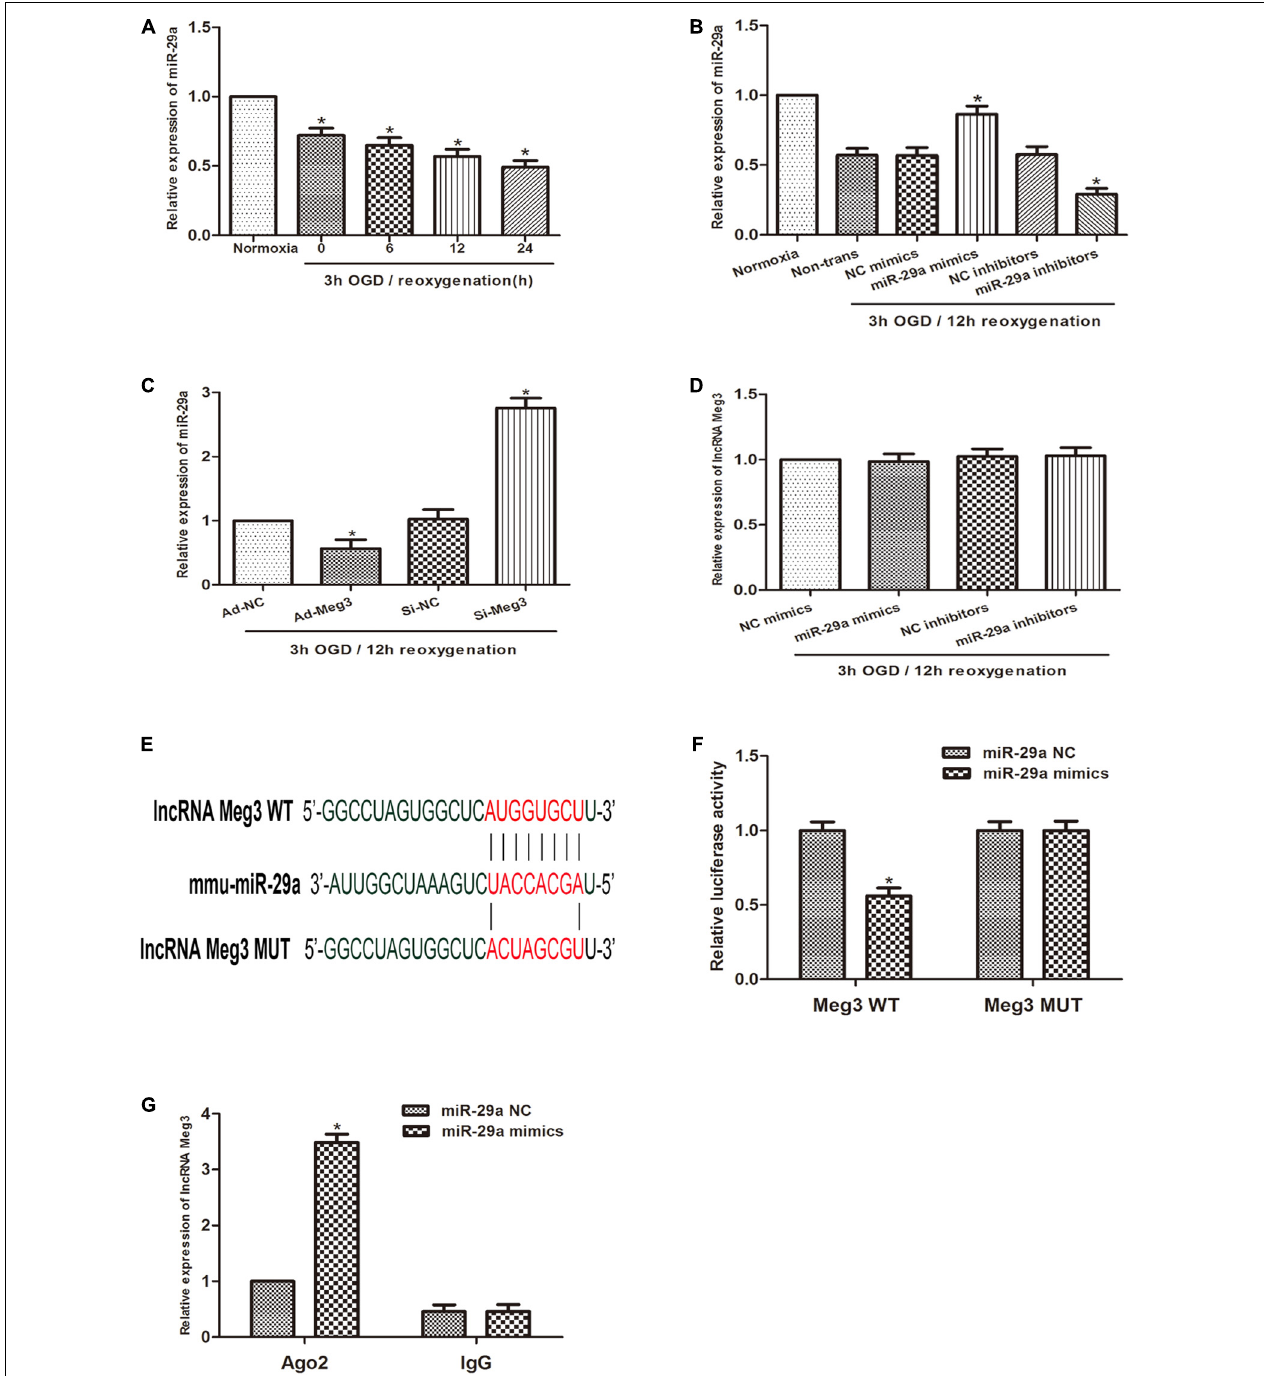
FIGURE 3 | lncRNA MEG3 inhibits miR-29a expression by directly targeting it. (A) Comparison of the relative expression levels of miR-29a between normoxic group and GC-1 cells at different reoxygenation times (0, 6, 12, and 24 h) after 3 h of OGD treatment. (B) Comparison of the expression level of miR-29a in cells transfected with miR-29a mimic or miR-29a inhibitor by qRT-PCR under normoxia or 3 h/12 h OGD/R treatment. (C) Comparison of the relative expression of MEG3 in cells transfected with ad-MEG3 and si-MEG3 by qRT-PCR under 3 h/12 h OGD/R treatment. (D) Comparison of the relative expression of miR-29a in cells transfected with miR-29a mimic or miR-29a inhibitor by qRT-PCR under 3 h/12 h OGD/R treatment. (E) Prediction of MEG3 binding sites to miR-29a. (F) A dual-luciferase reporter assay was executed to measure luciferase activity in cells cotransfected with miR-29a mimic and MEG3-WT or MEG3-Mut. (G) Comparison of MEG3 expression levels by RIP assay and qRT-PCR in cells transfected with miR-29a mimics or miR-29a NC. The data are presented as the mean ± S.E.M. n = 6. * p < 0.05 vs. control.